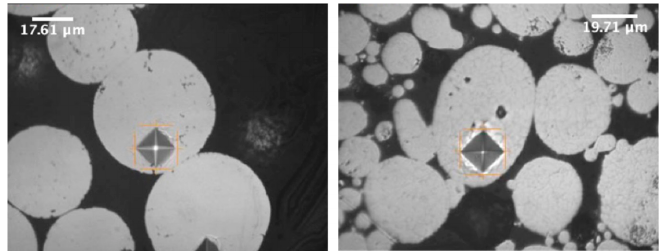
Figure 11. The resultant residual indentation associated with the application of a 0.01 kgf microindentation load with a Vickers-shaped tip. In both the ( Left ) and the ( Right ) micrographs, alloyed Al particles were embedded within a phenolic resin compression mounting matrix material. From the diagonal length of the rectangular “base” of the indent, one can clearly summarize that the depth to particle radii violate the Yan et al. model mentioned earlier. The limited microscope to indenter target location resolution is also observable due to the fact that the post-indentation imprints were non-centered and close to the edge of the particle-matrix interface.